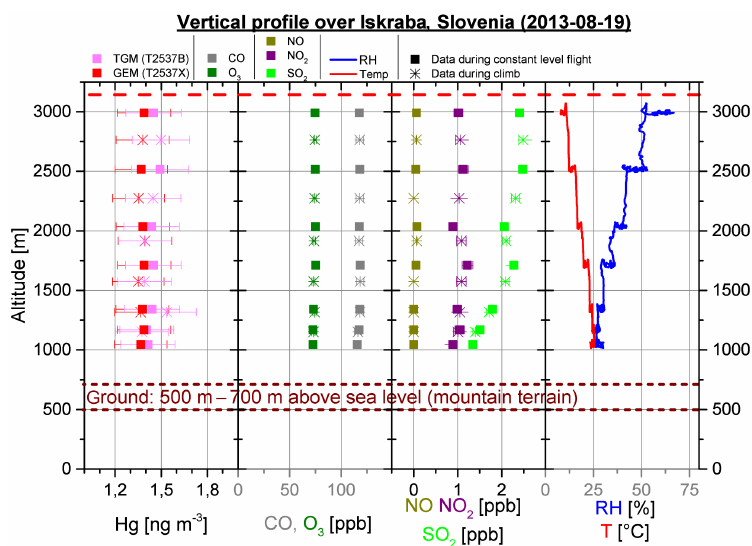
Figure 3. Vertical profile measured on 19 August 2013 from 13:17:30 to 14:07:30 (local time) over the GMOS master site Iskraba (45.561 ◦ N, 14.858 ◦ E, elevation: 530ma.s.l.; mountain terrain). Squares represent 300s averages with horizontal flight leg; stars indicate 150s averages during climbing between two neighbouring flight legs. The red dashed line indicates the planetary boundary layer (PBL) top, which is not representative here because all measurements were performed below the boundary layer top. GEM and TGM concentrations are given at standard temperature and pressure ( T = 273.15K, p =